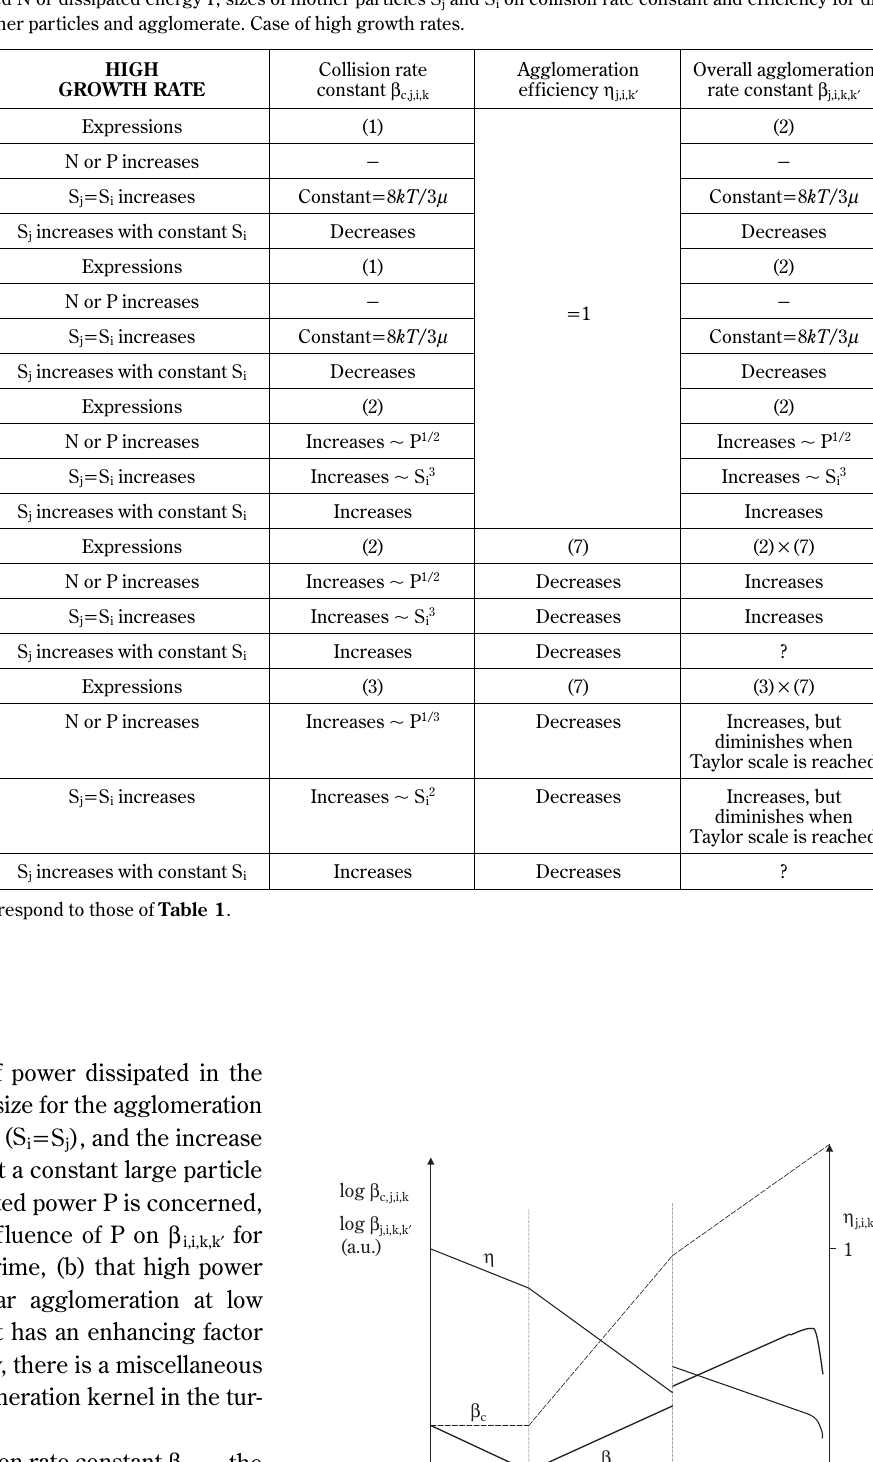
Table 3 Influence of stirring speed N or dissipated energy P, sizes of mother particles S j and S i on collision rate constant and efficiency for dif- ferent size ranges of mother particles and agglomerate. Case of high growth rates. Collision rate constant β c,j,i,k efficiency η j,i,k ′